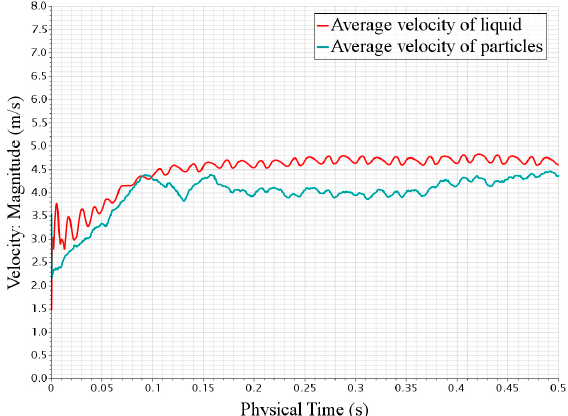
Figure 8. Variations in the volume-average velocities of the liquid and particles in flow domains.